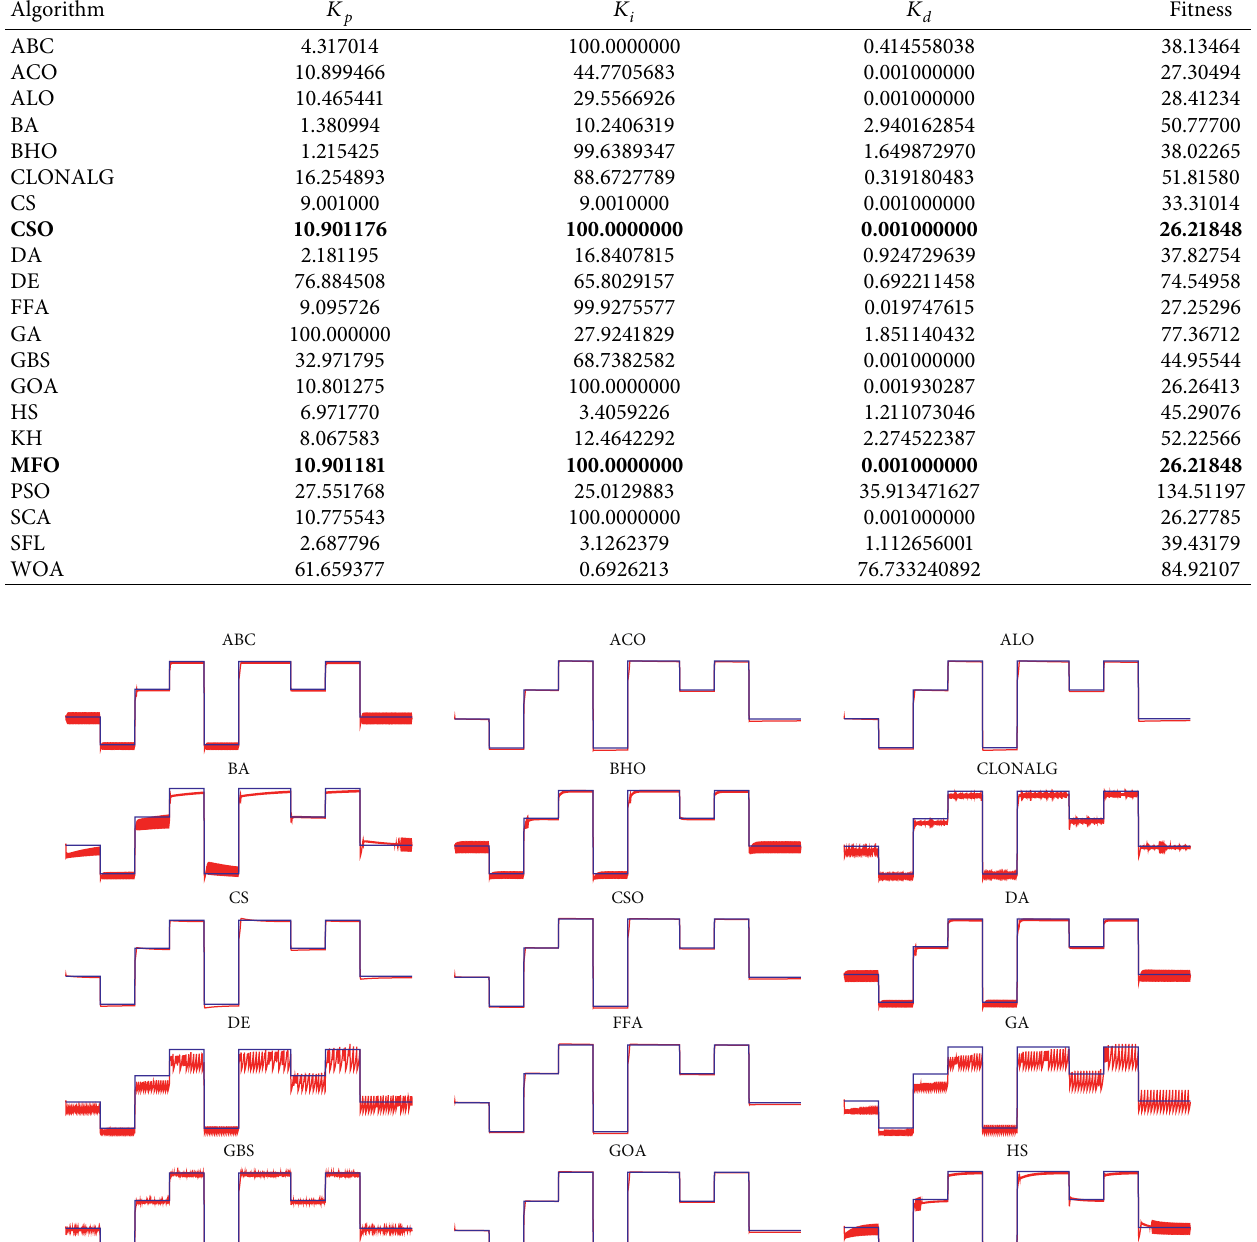
Table 7: Optimization solution values using proposed metaheuristics, using fitness f Algorithm